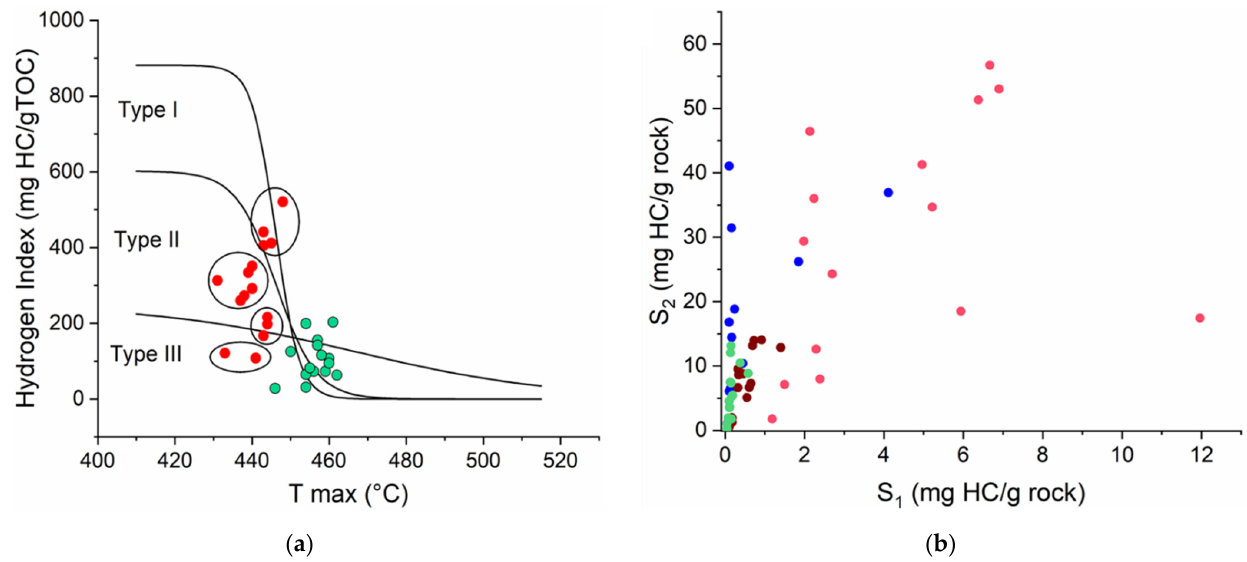
Figure 2. ( a ) Modified Van Krevelen diagram of original (red) and thermally treated (green) non-extracted oil shales; ( b ) S 2 and S 1 Rock-Eval parameters before the experiment and extraction (red), before the experiment and after extraction (blue), after the experiment and before extraction (brown), after the experiment and after extraction (green).